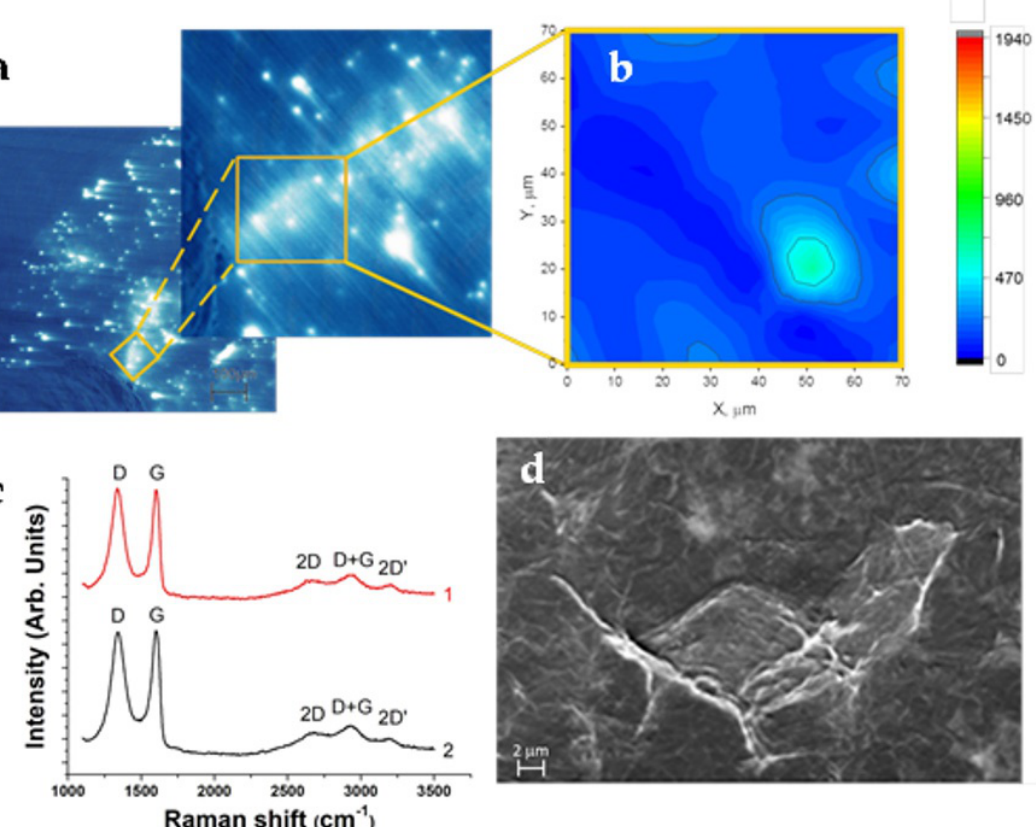
Figure 5. ( a ) EBIC image of a selected area showing higher and uniform intensity of the induced current; ( b ) Raman G-peak intensity map of the selected area marked in ( a ); ( c ) Raman spectra obtained on pristine GO film (red curve 1) and after resistive switching at maximum compliance current of 100 mA (black curve 2); ( d ) plain view SE image of pristine GO film.